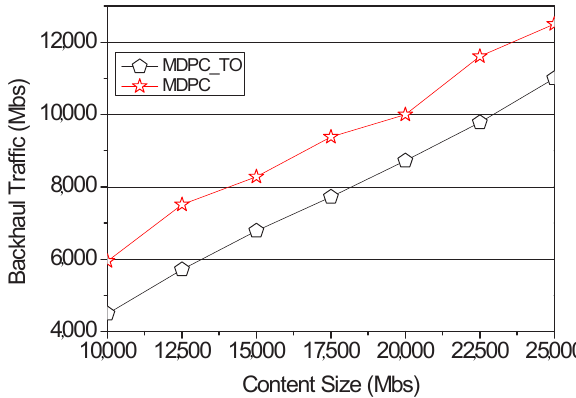
Figure 15. Backhaul traffic of optimization according to the content size.